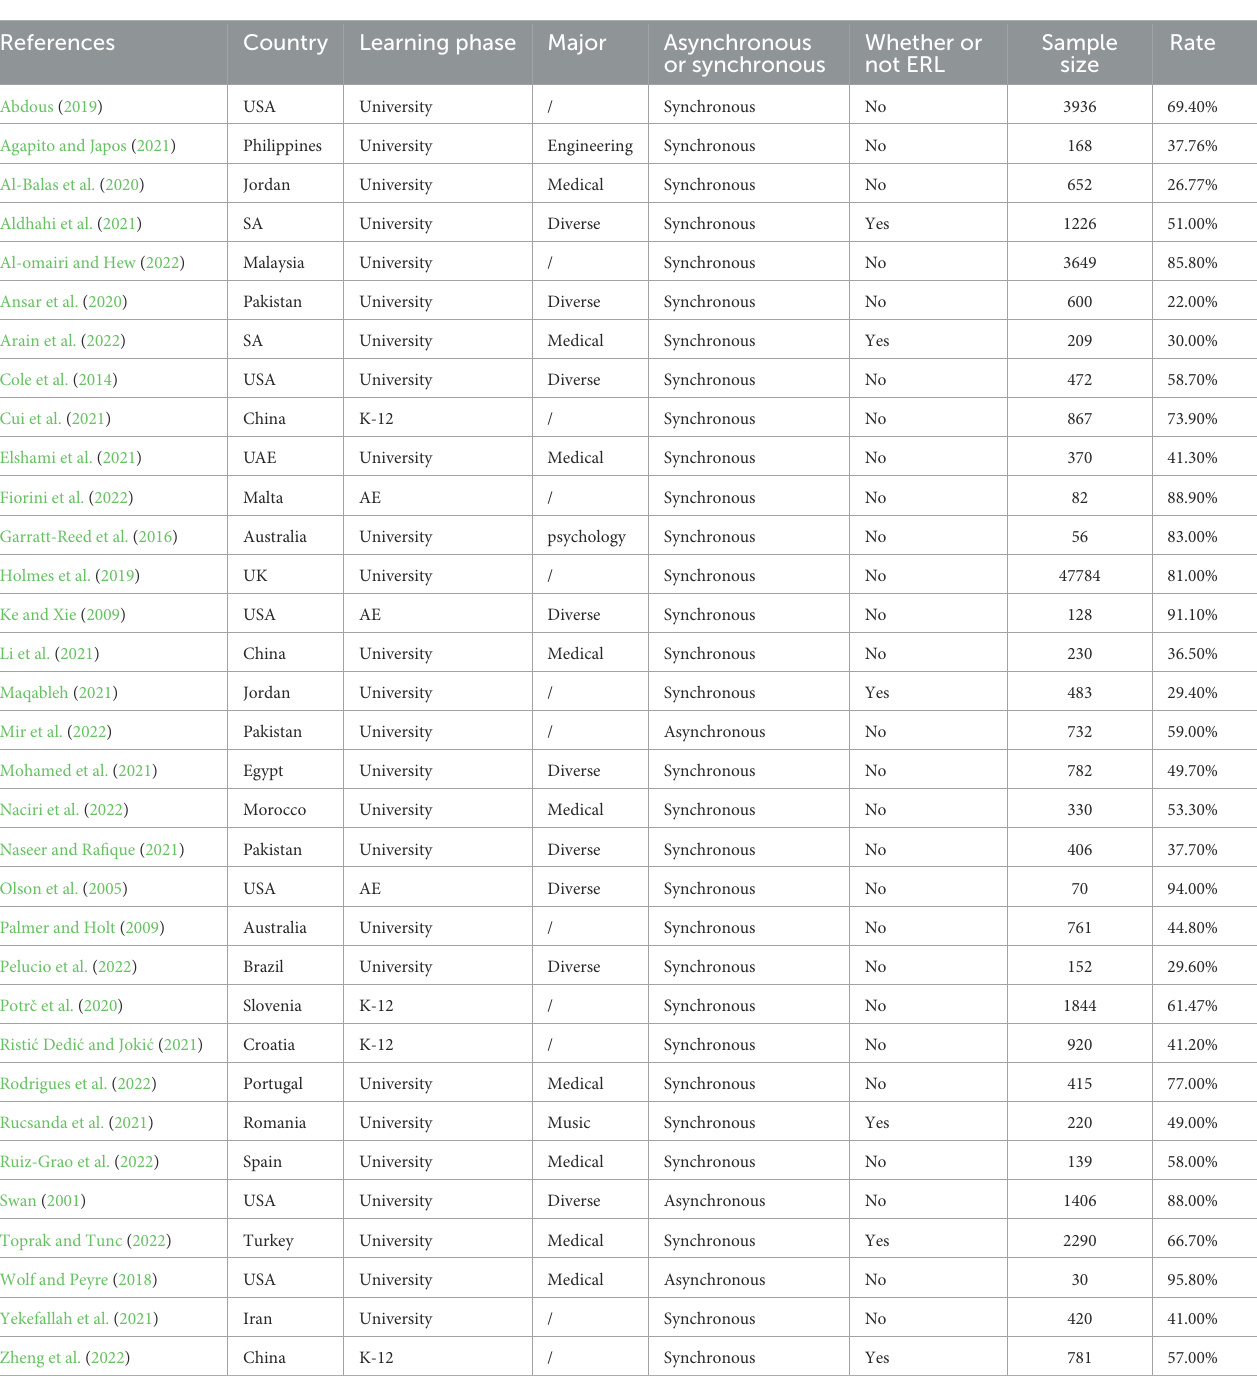
TABLE 1 Summary coding of included student satisfaction